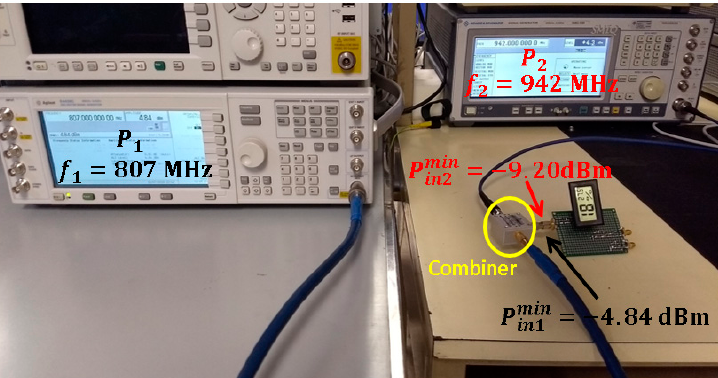
Figure 18. Measurement setup for the characterization of the minimum powers that turn on the temperature